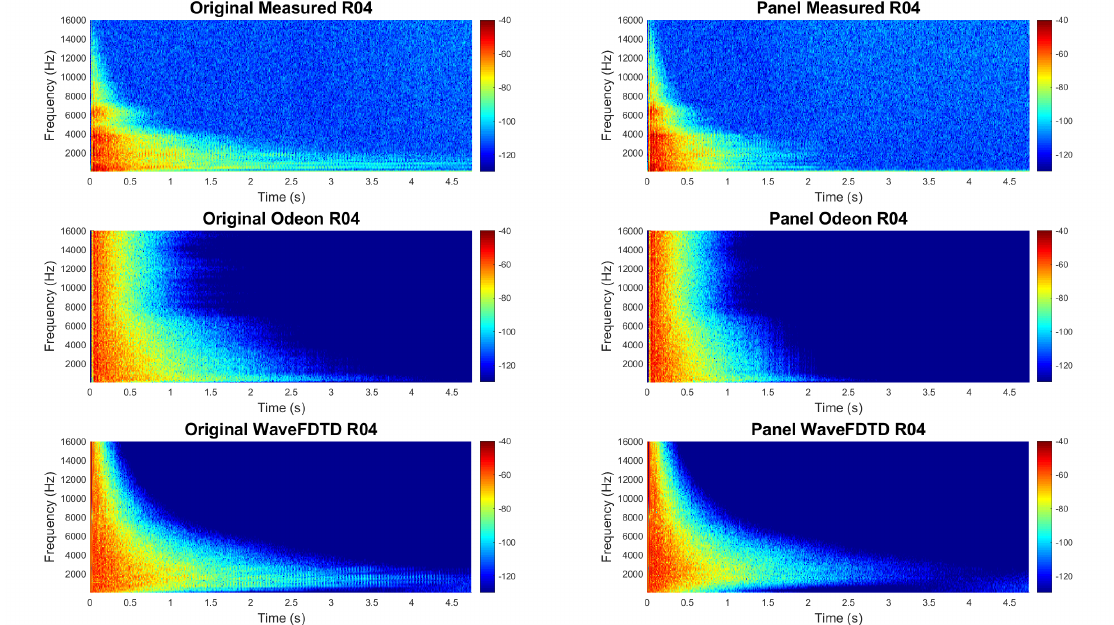
Figure 8. Spectrograms for receiver location R04 (on aisle 3m from source); before and after the addition of the acoustical panels. Note the presence of acoustical signals from 1.5–4.5s not observed in Figure 7